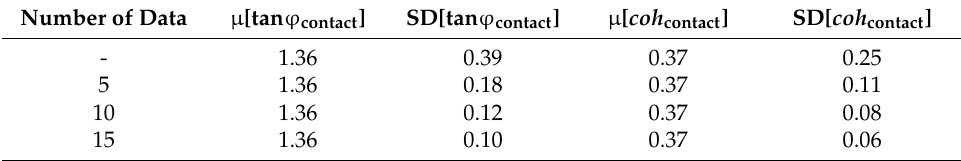
Table 6. Parameters of normal distributions for average friction coefficient and average